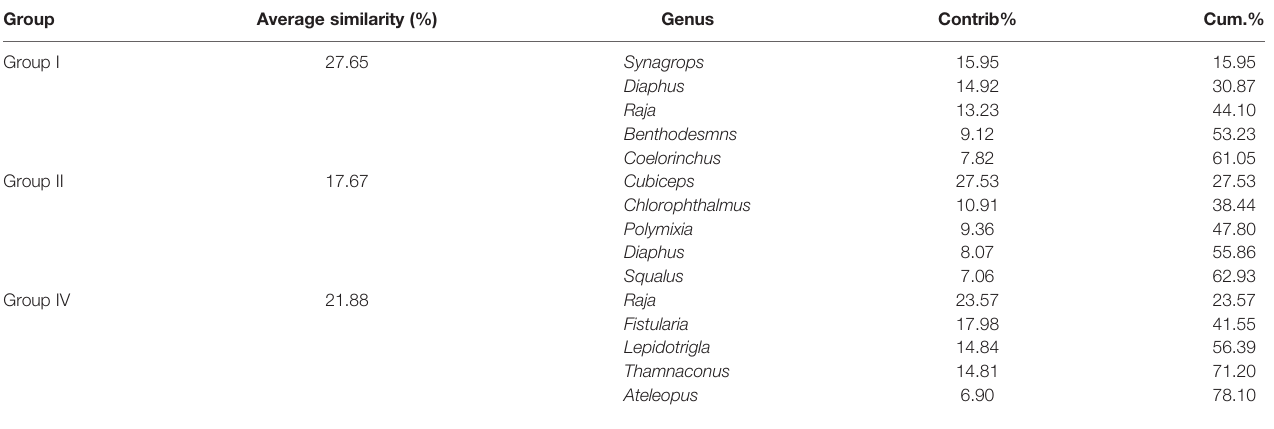
TABLE 4 | Intra-group average similarity of genus composition and top fi ve contributing genera over the NCSSCS. Group Average similarity (%) Genus